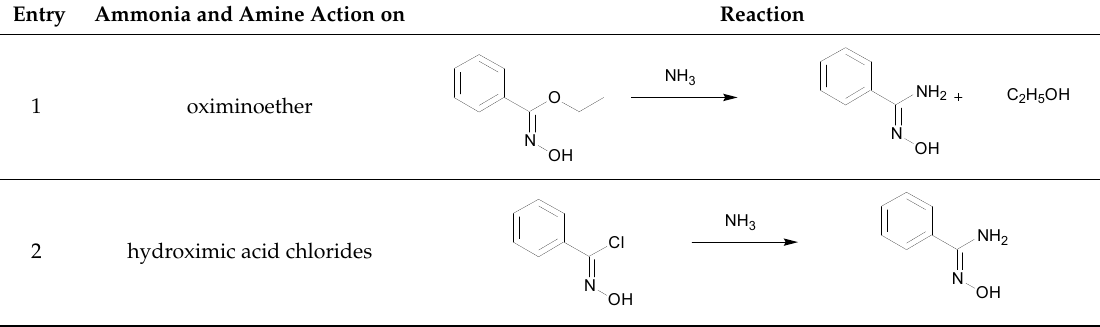
Table 3. Reaction of ammonia and amines with oximinoethers and hydroximic acid chlorides.